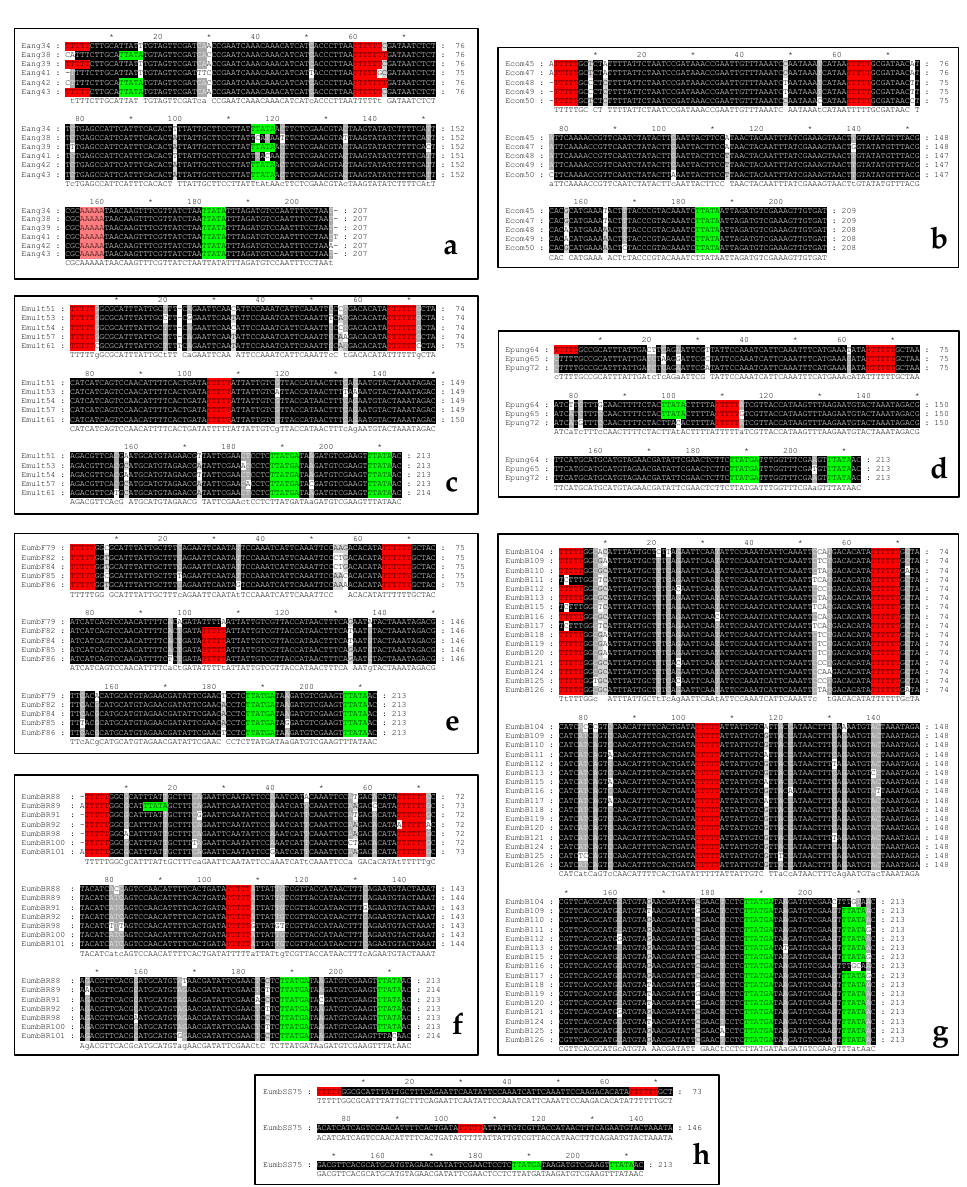
Figure 3. The alignment of the Elaeagnus angustifolia ( a ), E. commutata ( b ), E. multiflora ( c ), E. pungens ( d ), E. umbellata var. “Fortunella” ( e ), E. umbellata var. “Brilliant Rose” ( f ), E. umbellata without variety ( g ), and E. umbellata var. “Sweet’n’Sour” ( h ) NTSs. The poly-T regions are indicated by red. The poly-A region is indicated by pink. The TATA-like motifs are indicated by